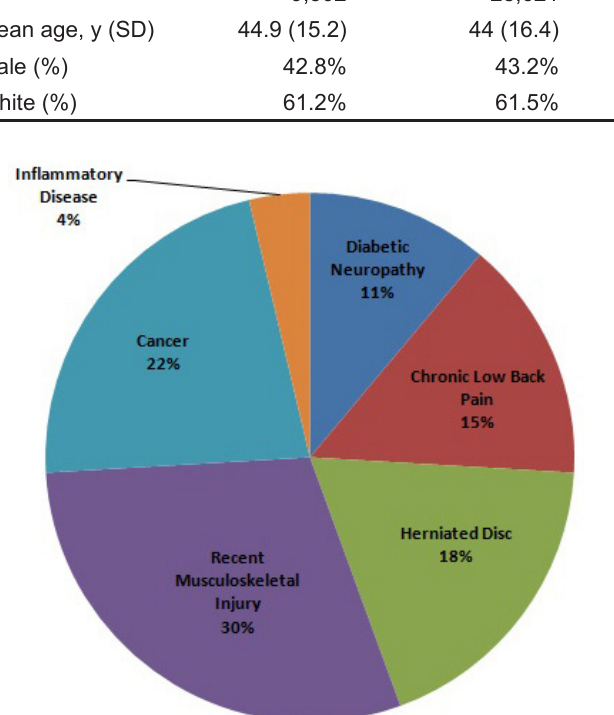
Figure 2 . Diagnosis of patients receiving opioid prescriptions for greater than 5 days